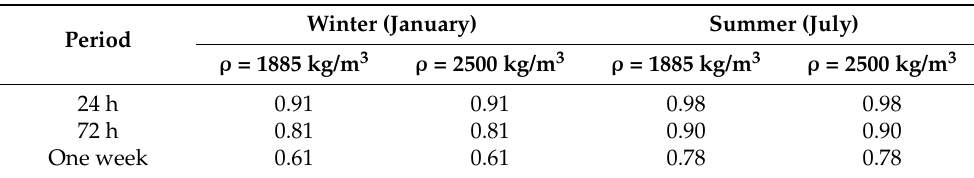
Table 6. R 2 correlation between measured dry-bulb temperature and simulation 1 ( λ in situ, Mass) depending on density ( ρ